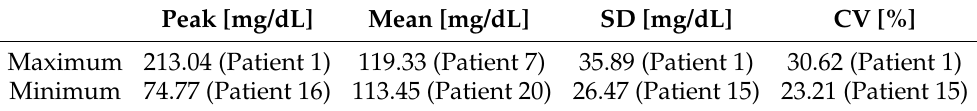
Figure 4. Mean insulin infusion and standard deviation for 20 patients and considering w 0 = 0 . Table 4. Glycemic metrics considering 20 patients and without prior basal